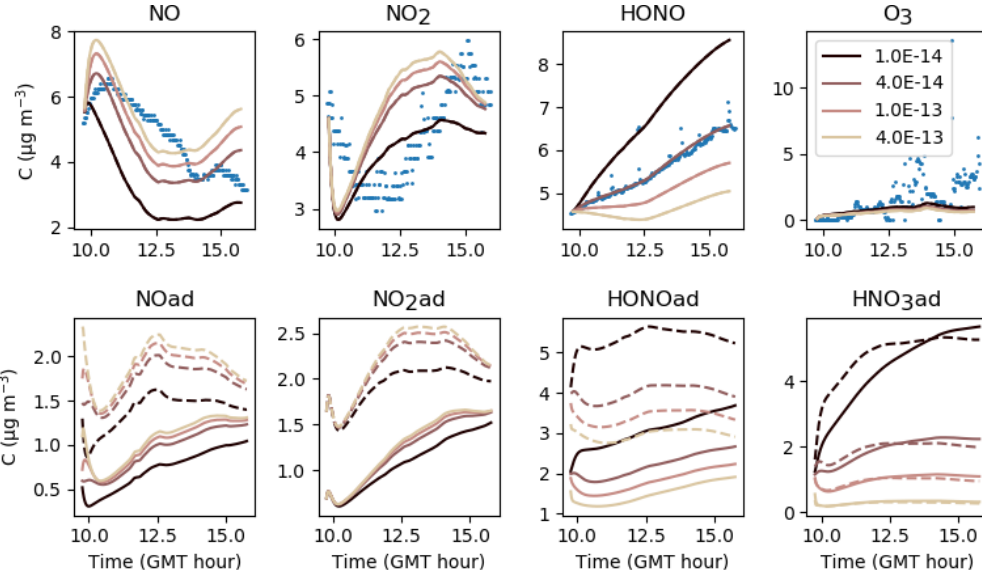
Figure 14. Gas-phase and adsorbed inorganic compounds simulated for different k S2 . The blue dots denote the experimental measurements (Experiment 2). The solid lines represent the concentrations in the sunlit box and the dashed lines the concentrations in the shaded box.